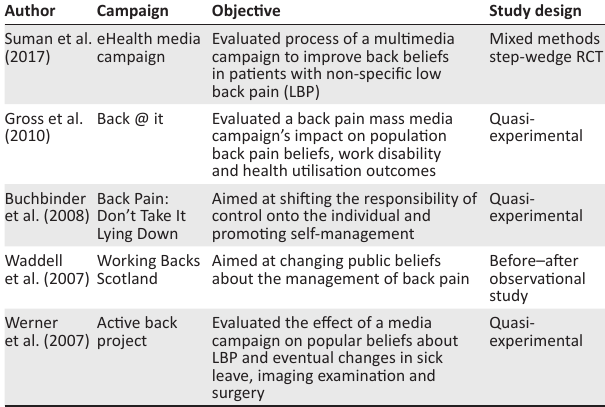
TABLE 3: Characteristics of included